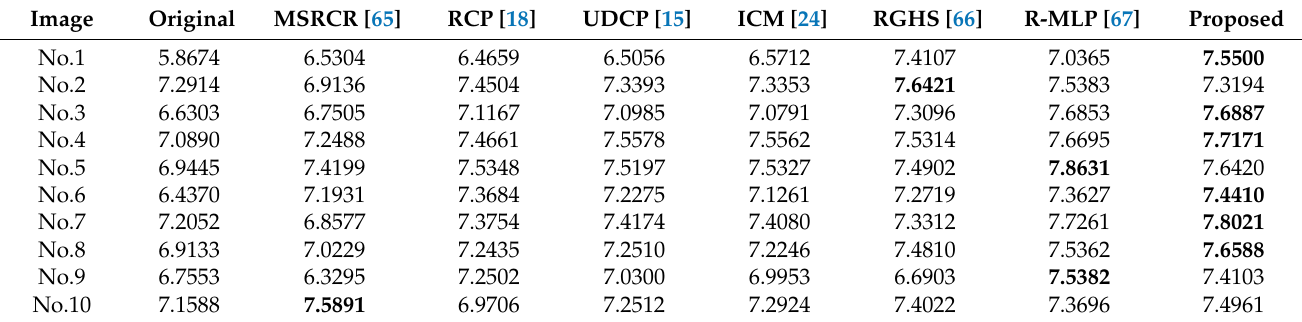
Table 5. Evaluation of images by information